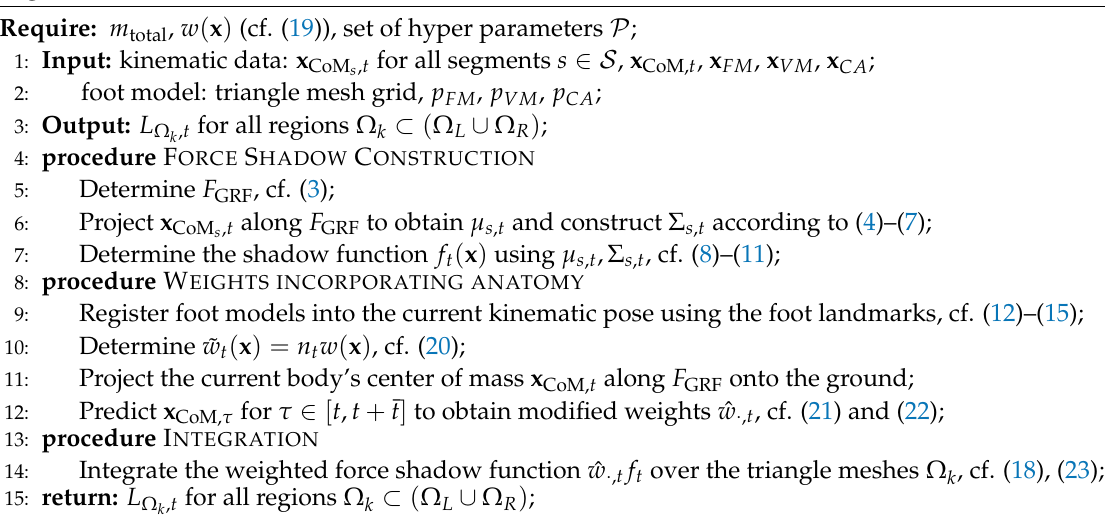
Algorithm 1 Force Shadow Method